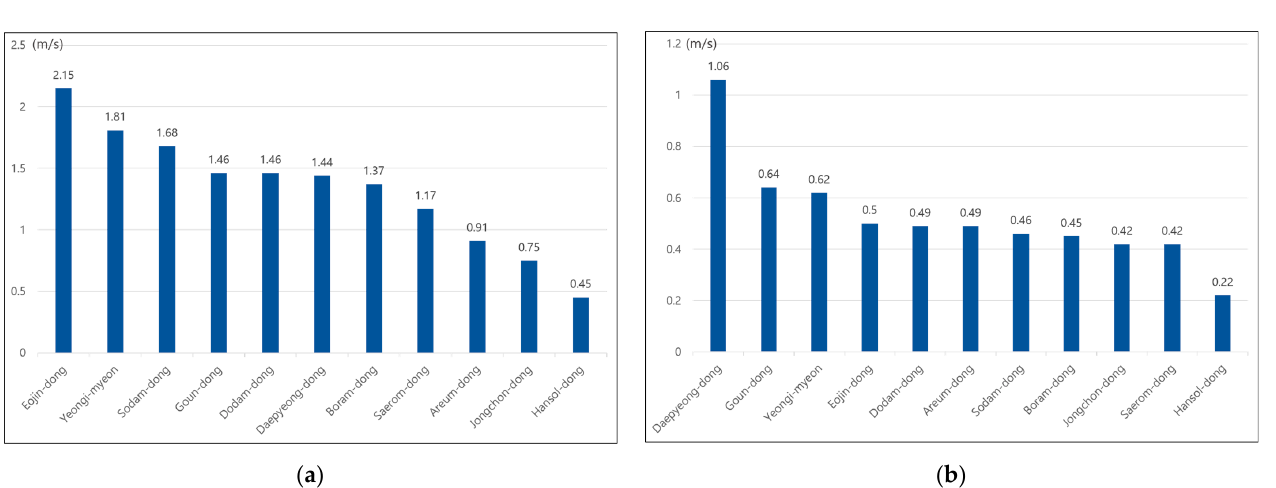
Figure 11. Comparison of wind corridor forest properties by administrative districts: ( a ) vegetation index of wind corridor forests; ( b ) proportion of three types of wind corridor forest.